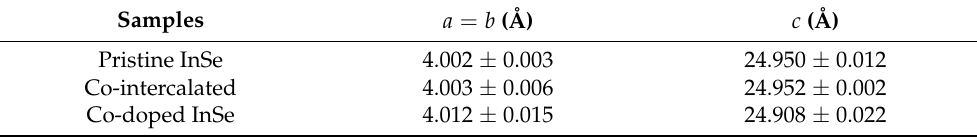
Figure 1. X-ray diffraction patterns recorded for InSe samples: as-grown pristine, Co-intercalated and Co-doped. Table 1. Lattice parameters ( a , b and c ) from the X-ray diffraction studies of the InSe